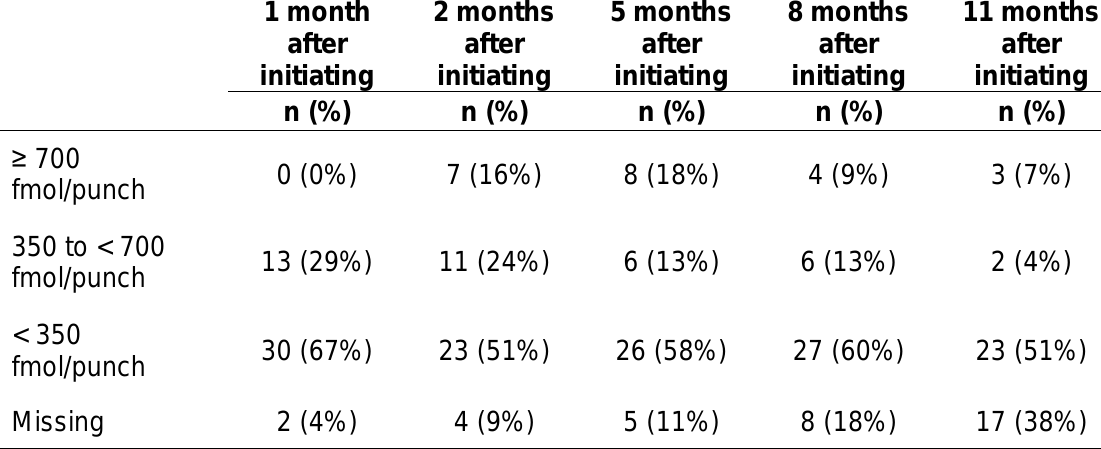
TABLE A1-1: Dried blood spot tenofovir-diphosphate adherence data ( N = 45) among South African men who have sex with men and transgender women in a combination HIV prevention trial,